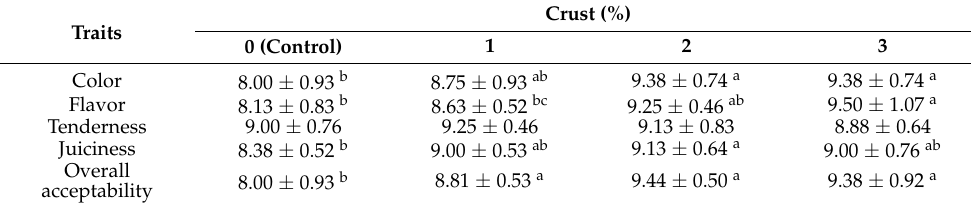
Table 4. Sensory evaluation of pork patties formulated with various levels of crust derived from dry-aged beef